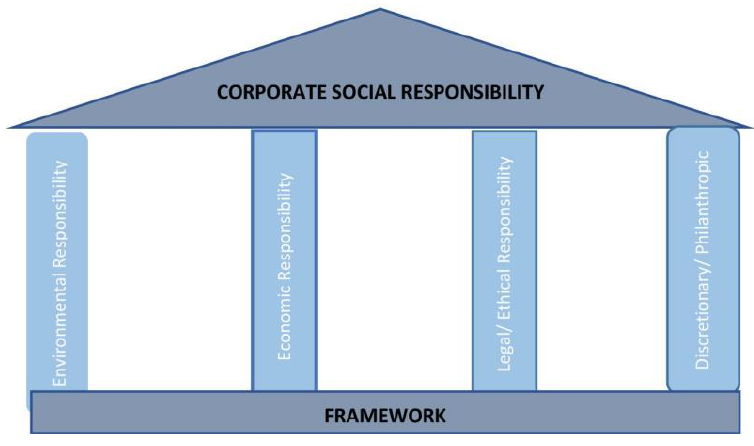
Figure 1: Types of corporate social responsibility; Source: